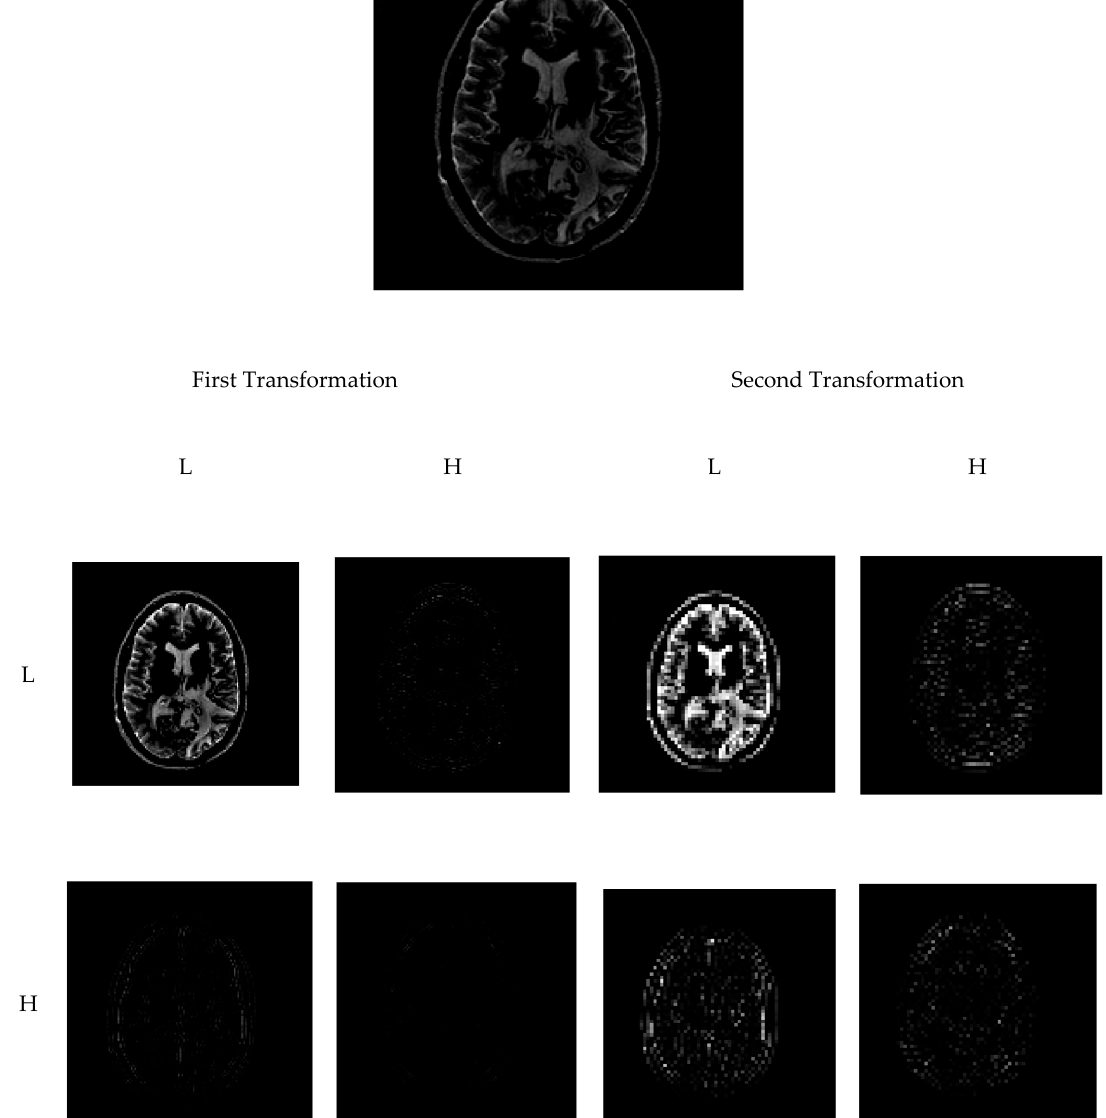
Figure 4. The sub-bands of the wavelet transformation using homomorphic filtering.